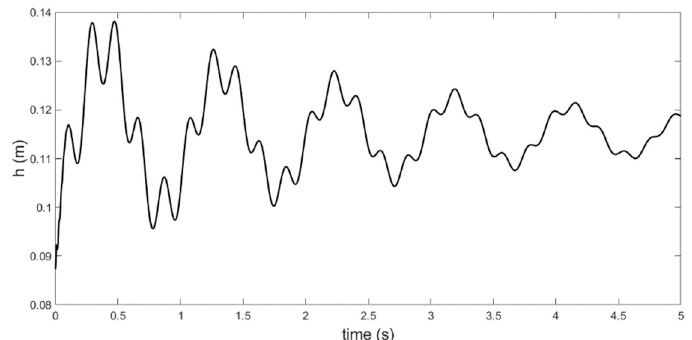
Figure 7. Time response of “h” in lower speed of flutter (20 m/s).